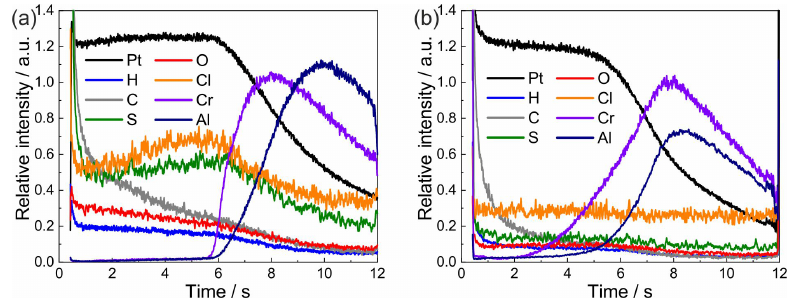
Figure 7. GDOES depth profiles of an electroless-deposited sample ( a ) in as-deposited state and ( b ) after annealing at 1100 ◦ C for 4 h in